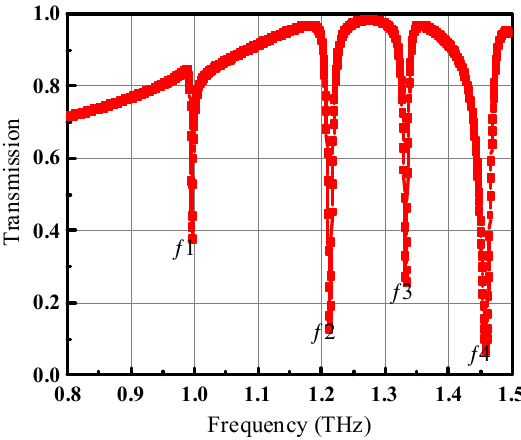
Figure 2. The transmission characteristic curve of the four-band sensor.